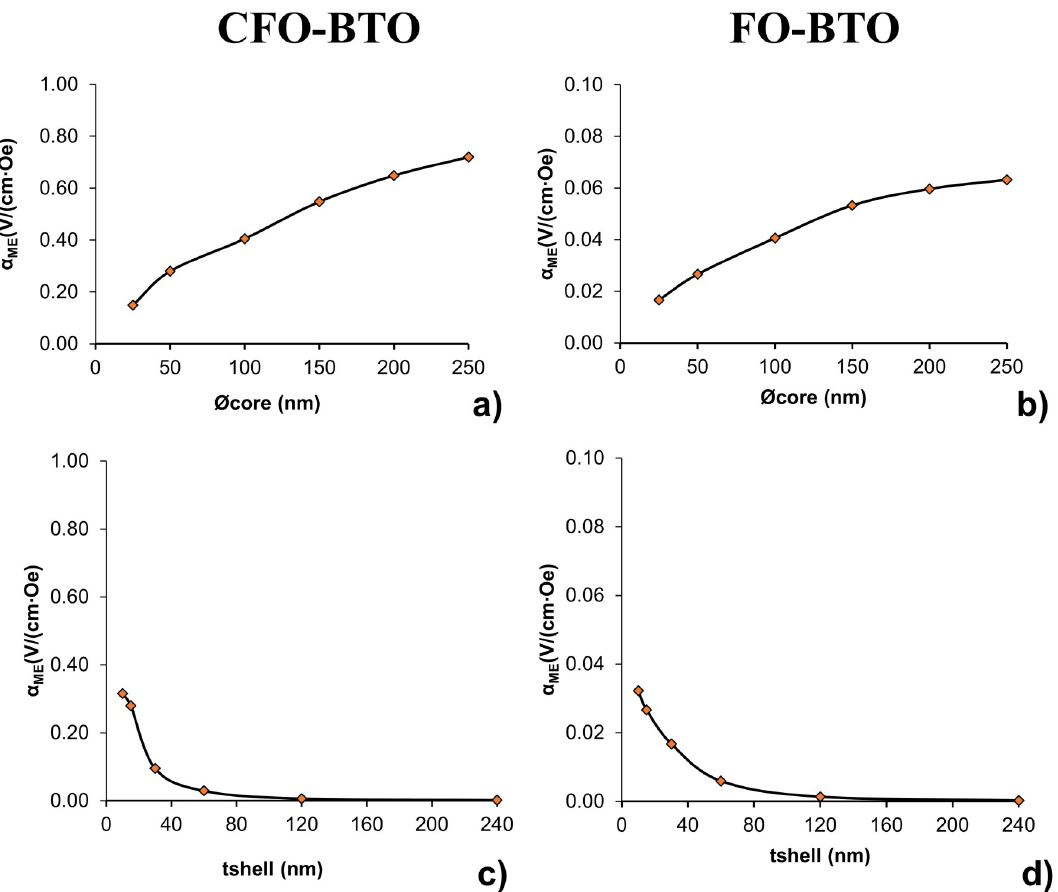
Fig 1. MENP computational modeling. Schematic representation of: a) the geometrical parameters of a generic core-shell MENP; b) the simulation settings in the three different analyses performed; c) the computational study workflow.